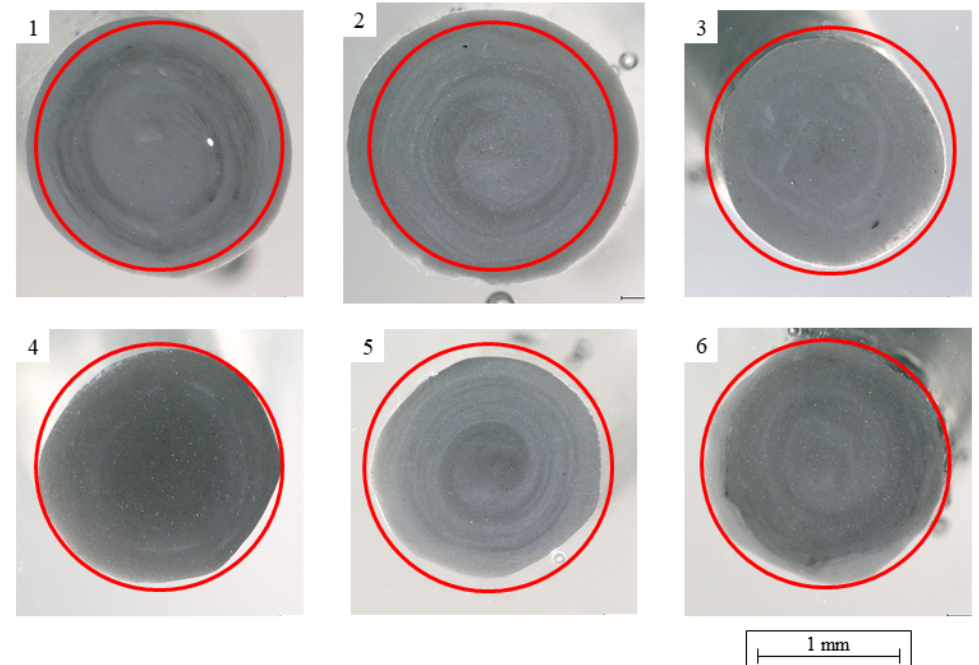
Figure 8. Microscopic analysis of six samples of the coextruded filament with a 20% skin layer, where the circle marks an ideal cross-section with d = 1.75